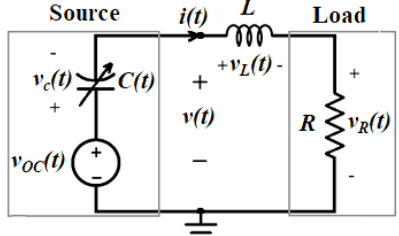
Figure 12. Complete equivalent circuit model for a spiral electrode TENG.